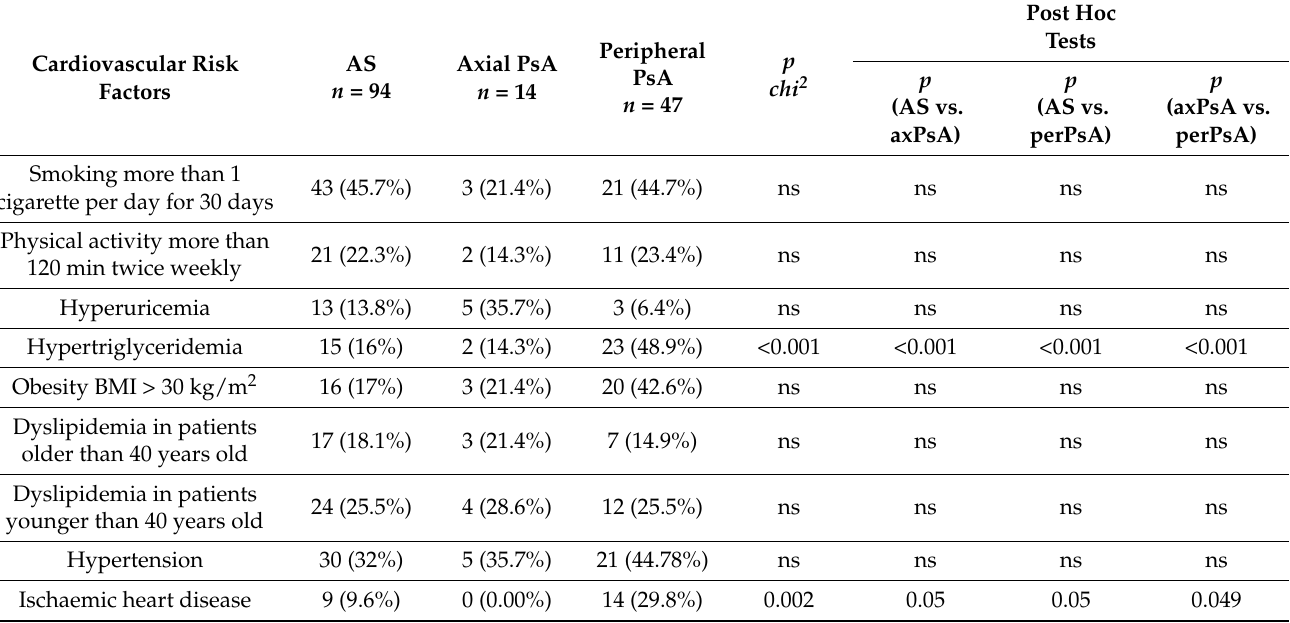
Table 2. Cardiovascular risk factors in axial PsA, peripheral PsA and AS groups. Differences statistically significant with p < 0.05 are